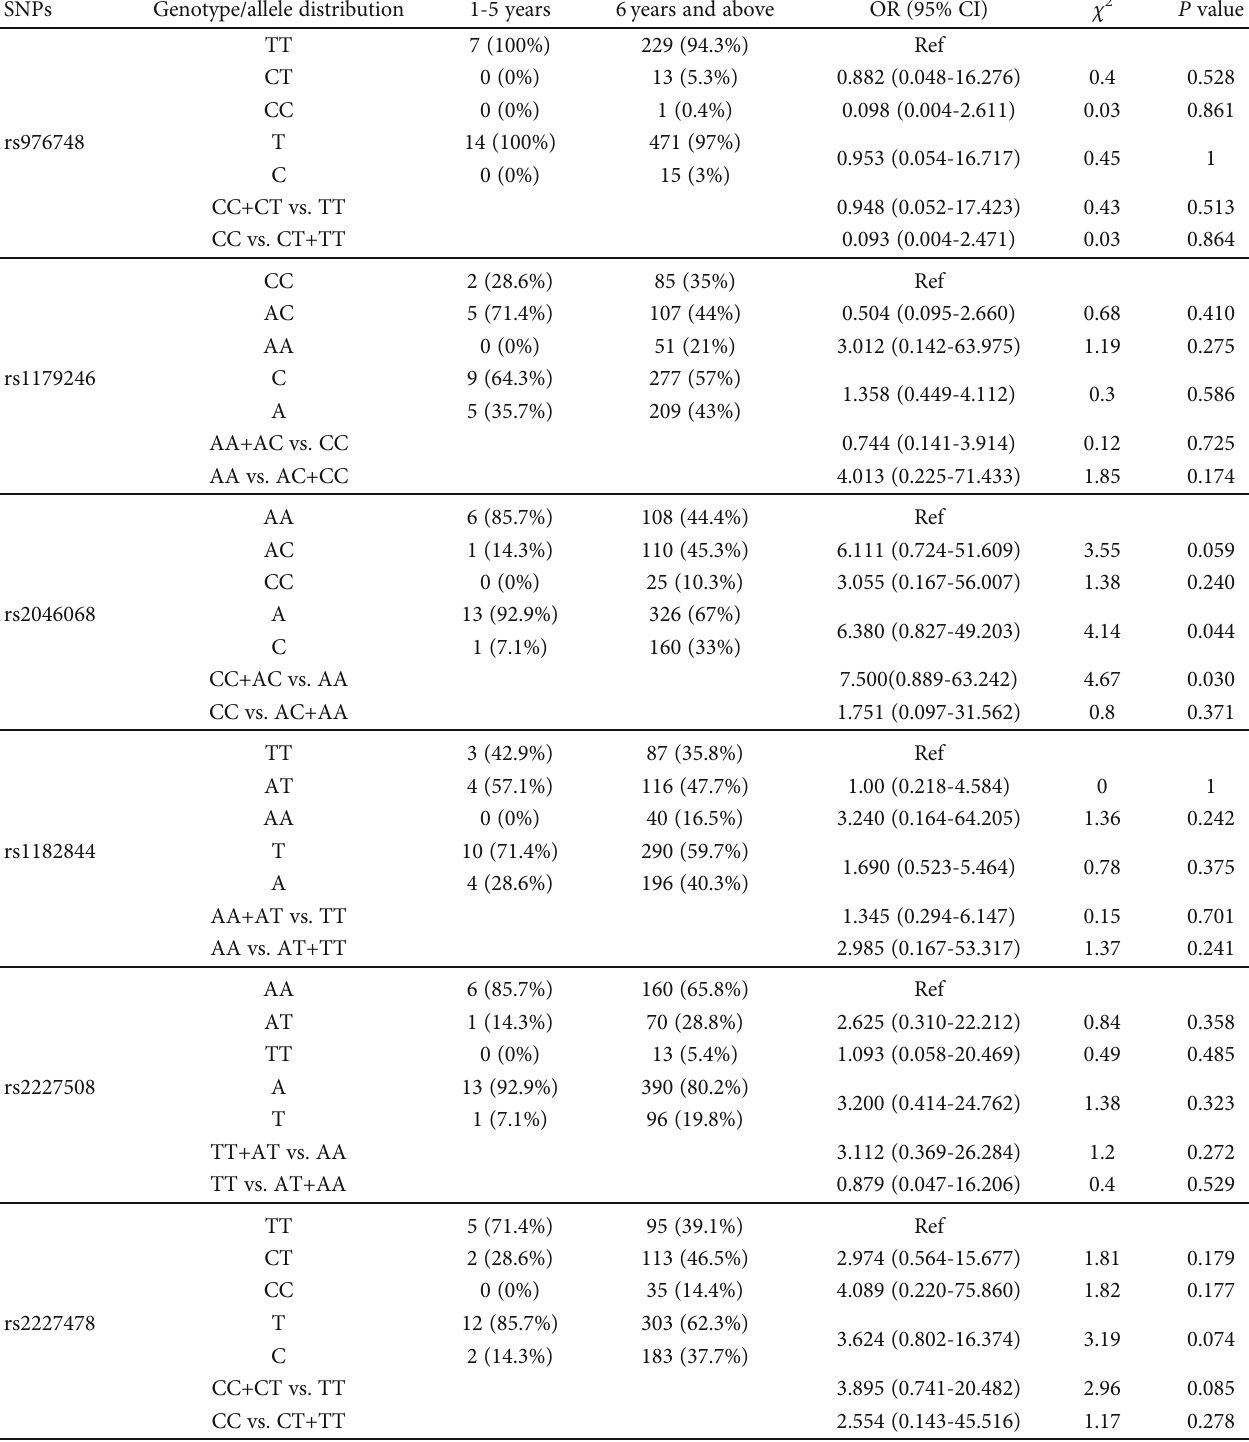
Table 3: Genotype distribution and allele frequency of IL-22 SNPs in group 1-5years of age compared to 6 years and above age